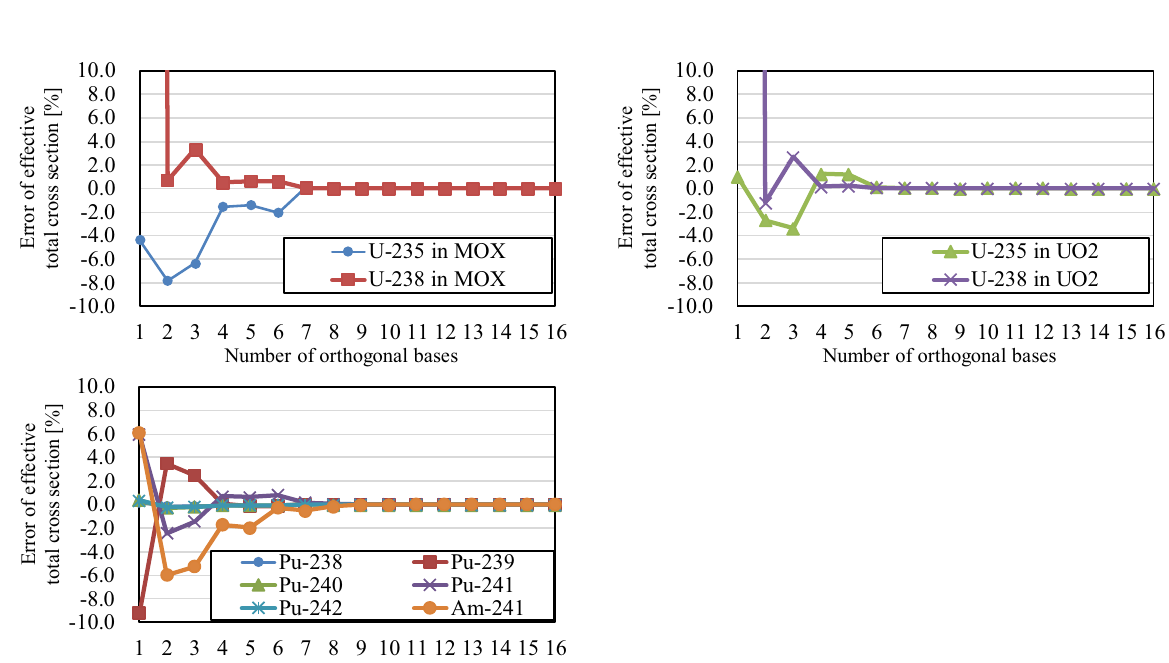
Figure 3. Comparison of effective total cross section in group 88 for various number of orthogonal bases in Fig. 1-(b).